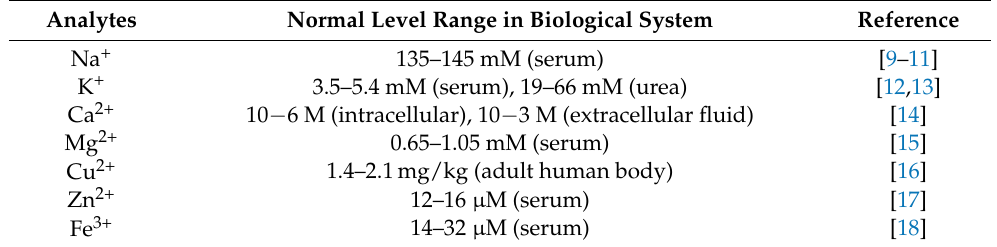
Table 1. Normal level range of essential metal ions commonly found in biological